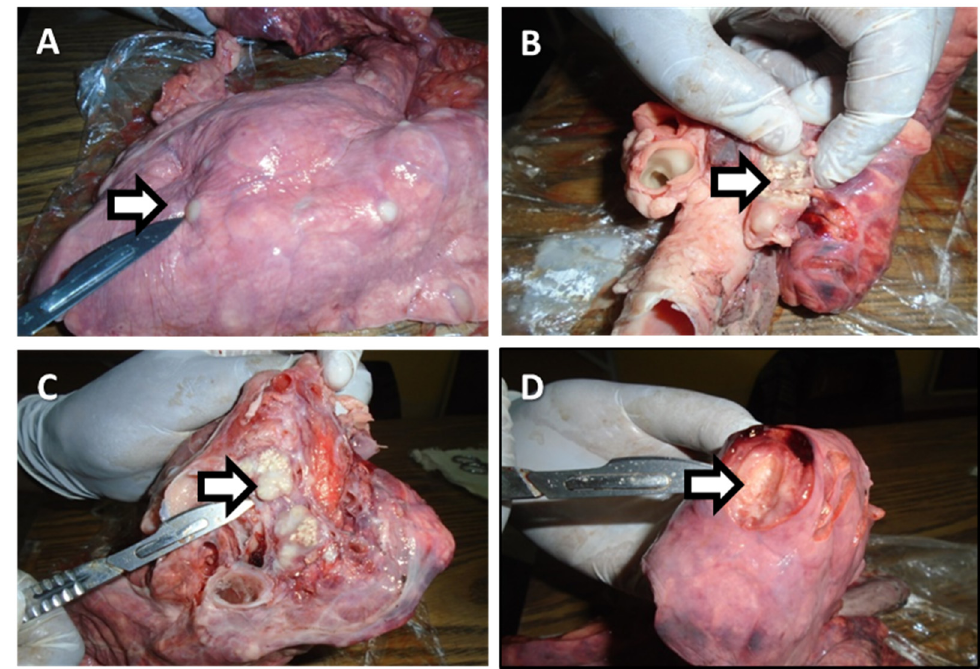
Figure 2. Typical TB lesions (indicated by an ) of cattle slaughtered at Debre Birhan town municipal abattoir: ( A ) nodules in the lungs of an ox; ( B ) caseation of bronchial lymph node in the lungs of an ox; ( C ) calcified mediastinal lymph node in the lungs of cow; ( D ) white spots in the lung tissue of an ox. Table 5. Distribution of lesions based on anatomical sites.